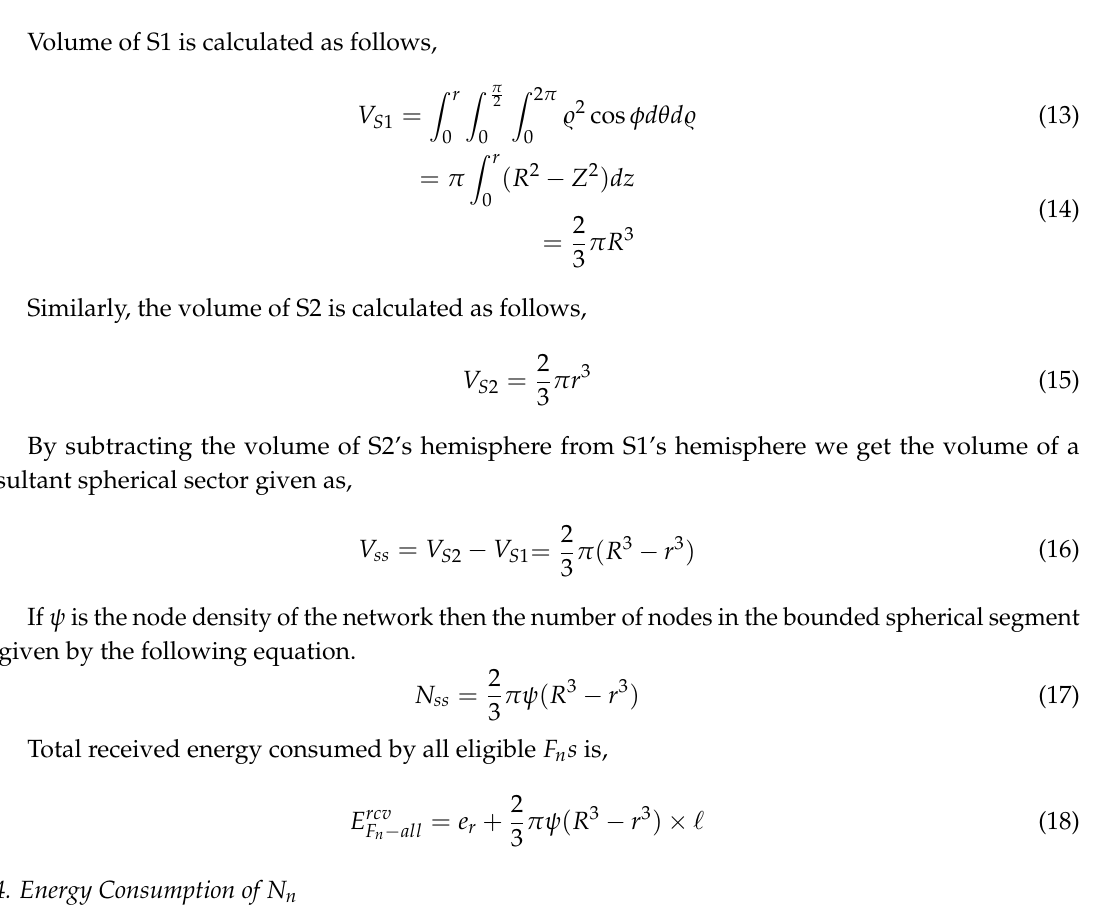
Figure 1. Hemispherical volume of existence of F n